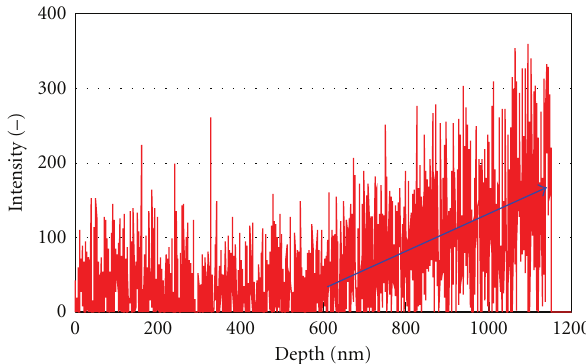
Figure 15: Cu element profile through thickness direction of the Cr-doped TiO 2 film under the condition of N top = 7 by XPS analysis.